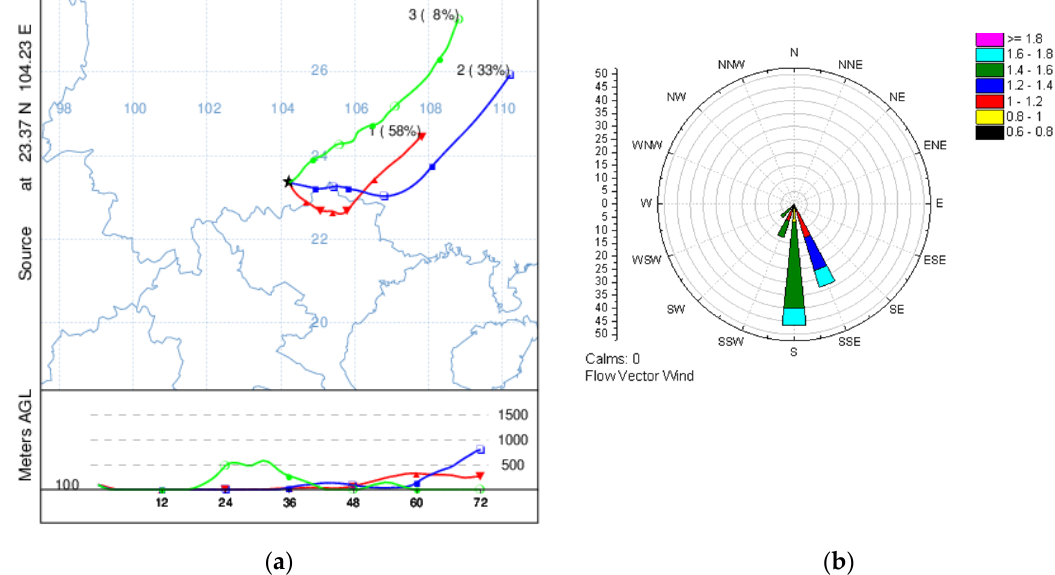
Figure 7. ( a ) The mean 72 h backward trajectories of each trajectory cluster during autumn and the percentage of allocation to each cluster. ( b ) Wind roses of Wenshan during autumn